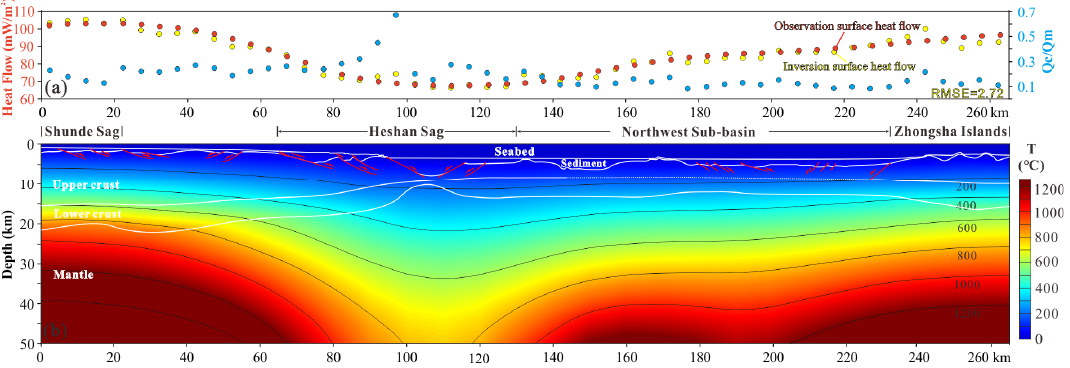
Figure 5. ( a ) The heat flow from observation and inversion along profile L2 are represented by red and blue points, respectively. The ratio between crustal heat flow and mantle heat flow is indicated by yellow points. Q c , crustal heat flow; Q m , mantle heat flow. ( b ) Thermal structure calculated from the simulation of profile L2.